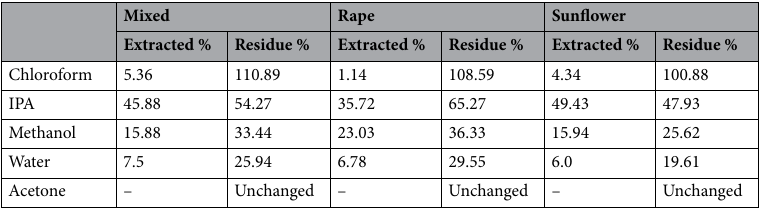
Table 1. Alteration of the dry mass of bee pollen samples following Soxhlet extractions and a final aqueous and acetone wash, compared to the initial dry mass content.